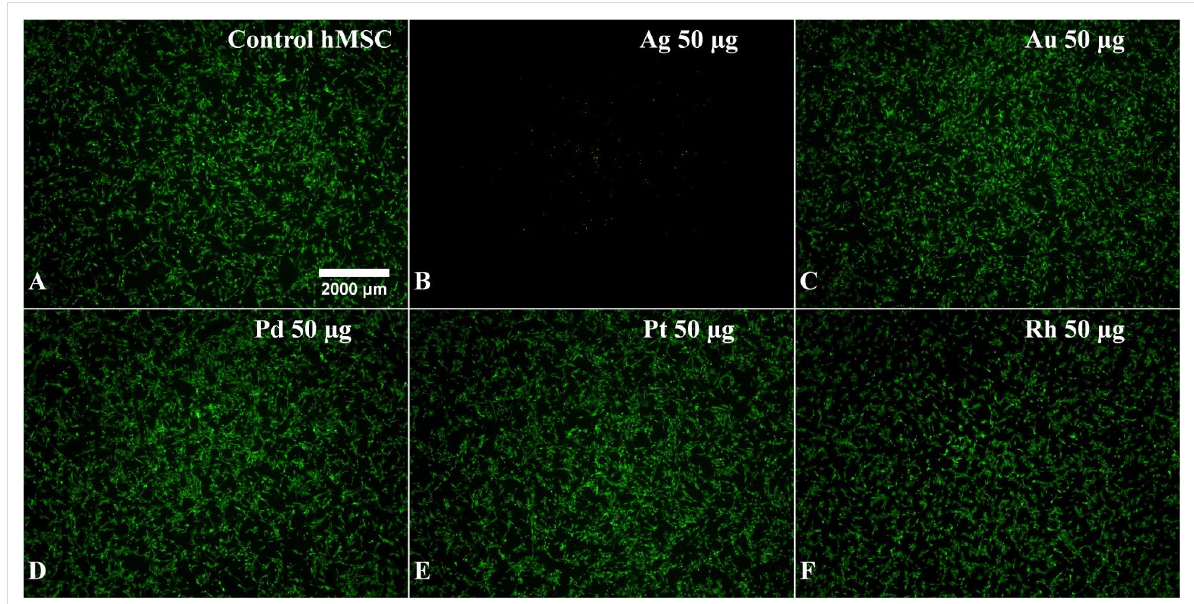
Figure 6: Effects of nanoparticles on the viability and the morphology of human mesenchymal stem cells (hMSCs). hMSCs in 24-well cell culture plates were incubated with different nanoparticles (50 µg mL − 1 = 50 ppm) under cell culture conditions and subsequently stained with calcein-AM. Viable cells are indicated by green fluorescence (A: control: untreated hMSC).